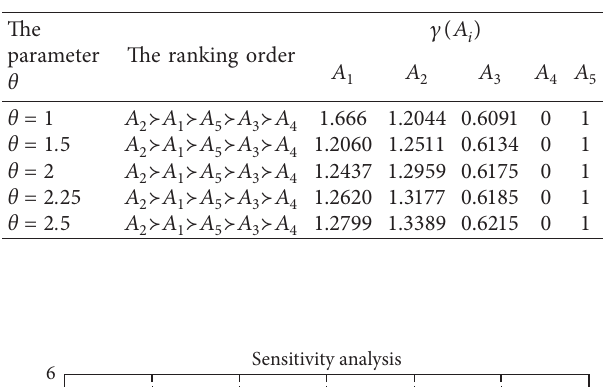
Table 6: The ranking-order results of alternatives for each different value of the parameter θ .